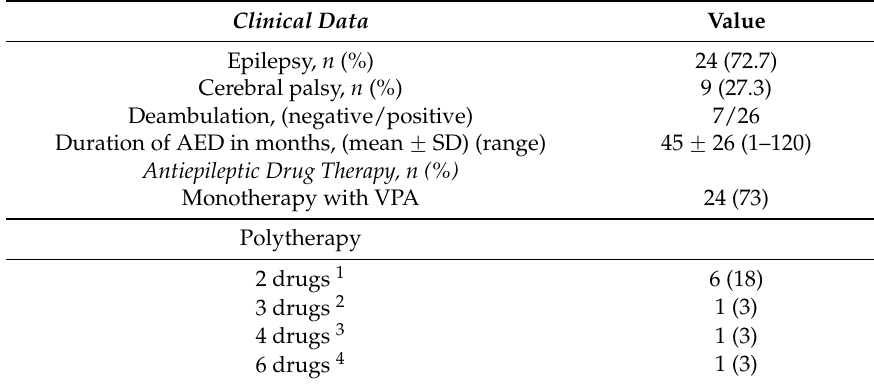
Table 2. Clinical characteristics of the treatment group.